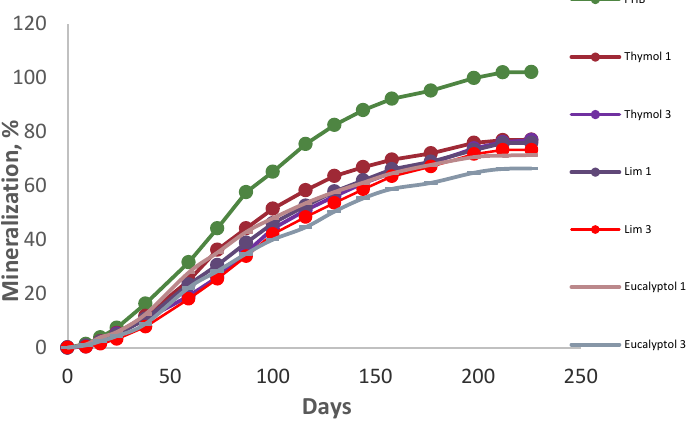
Figure 1. Mineralization of the additives at room temperature.